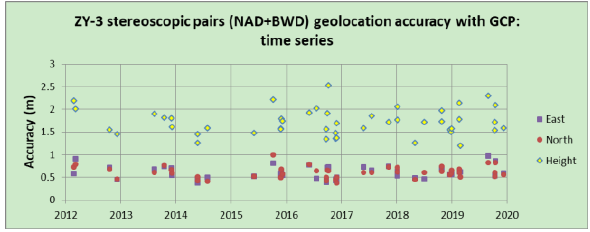
Figure 16. ZY-3 stereoscopic pairs (NAD+BWD) geolocation accuracy with GCP